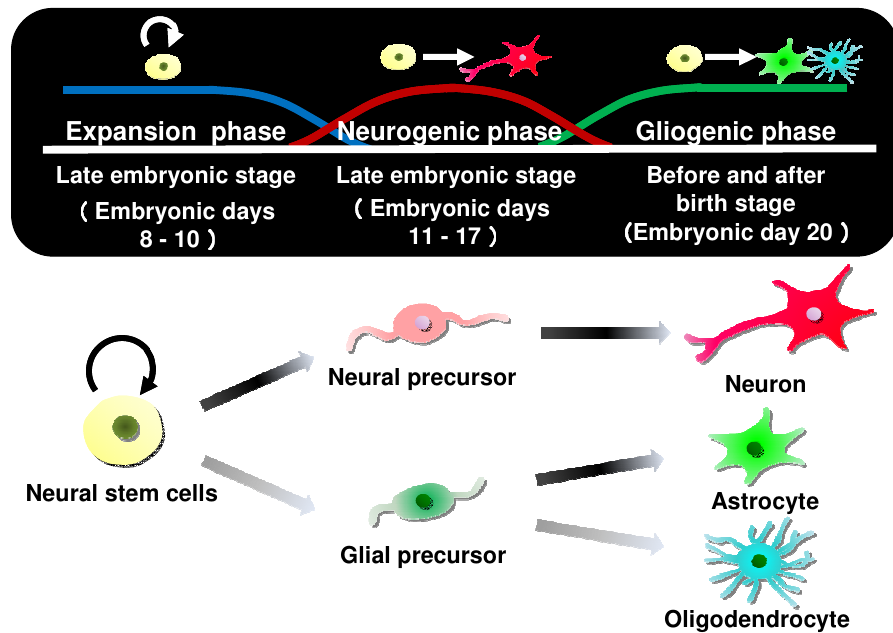
Figure 5. Di ff erentiation of neural stem cells in the Figure 5. Differentiation of neural stem cells in the brain.